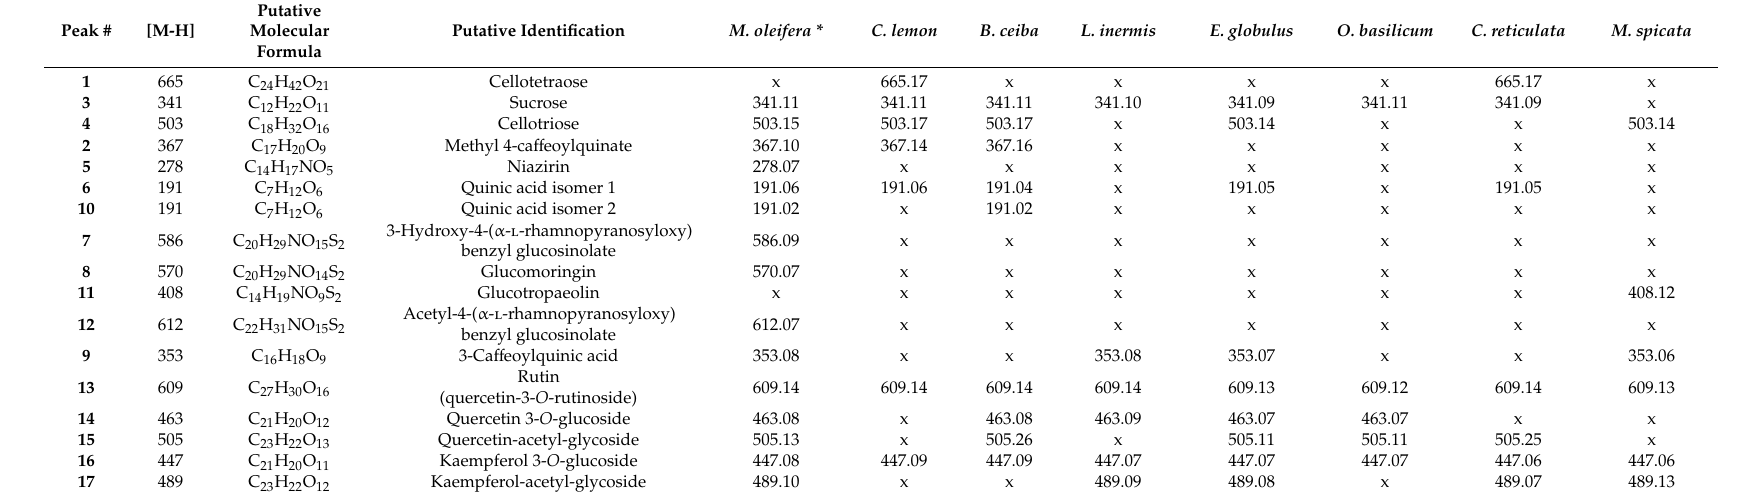
Table 2. LC-MS / MS identification of plant